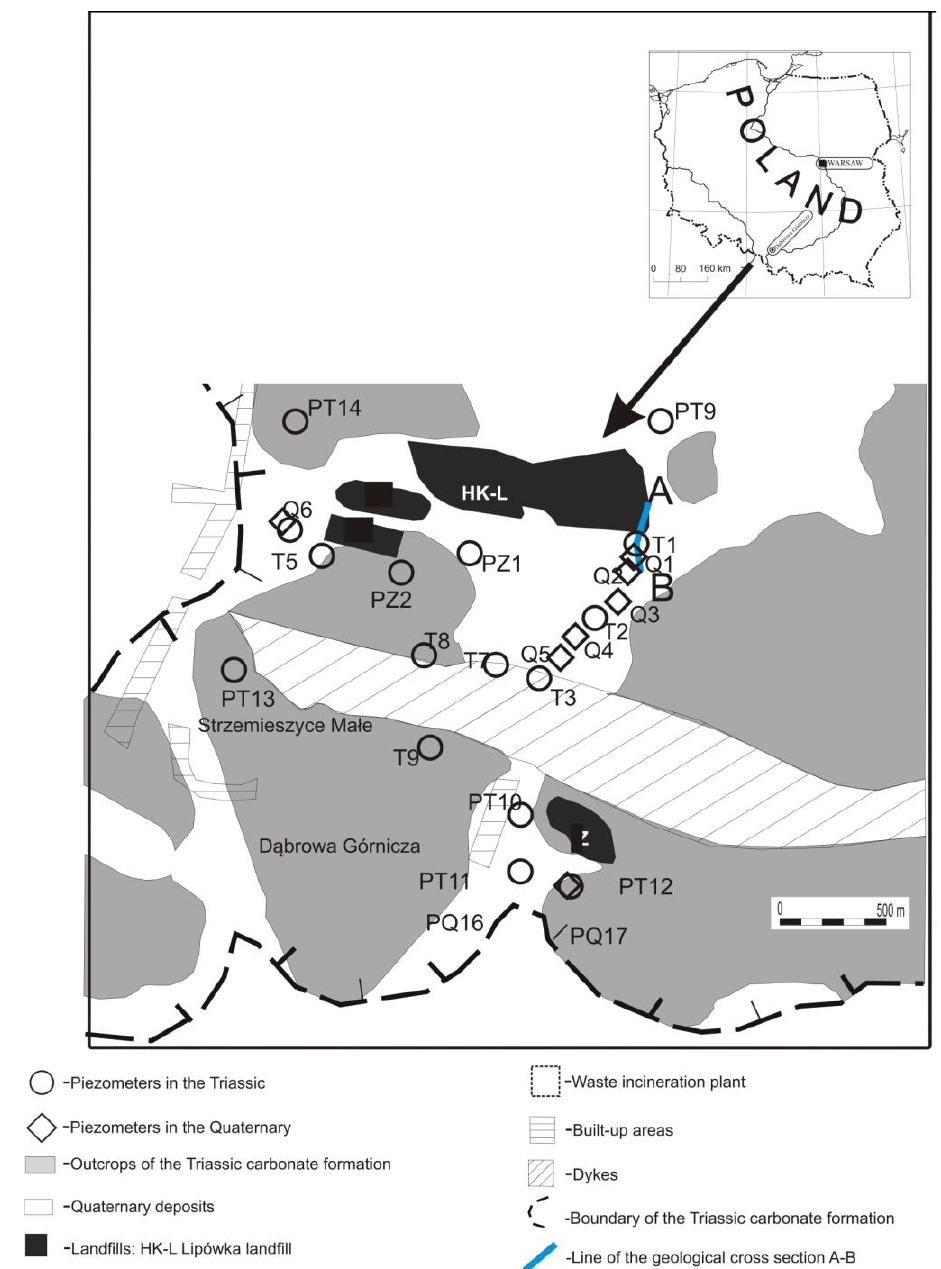
Fig. 1. The location of Lipówka landfill